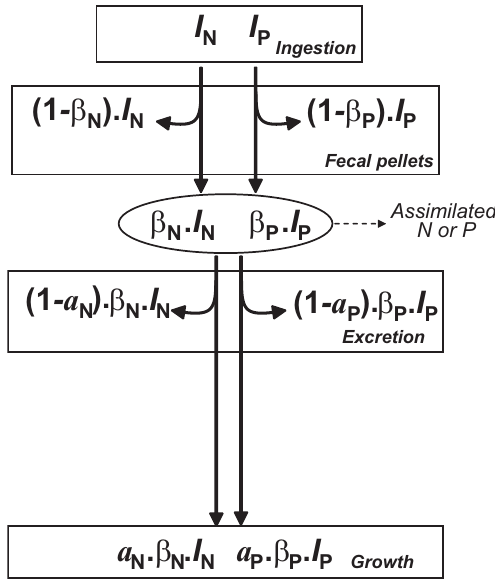
Fig. 3. Fluxes of N and P in herbivores. I i is the ingestion (mmolm − 3 yr − 1 ), β i is the assimilation efficiency, and a i is the accumulation efficiency ( i =N or